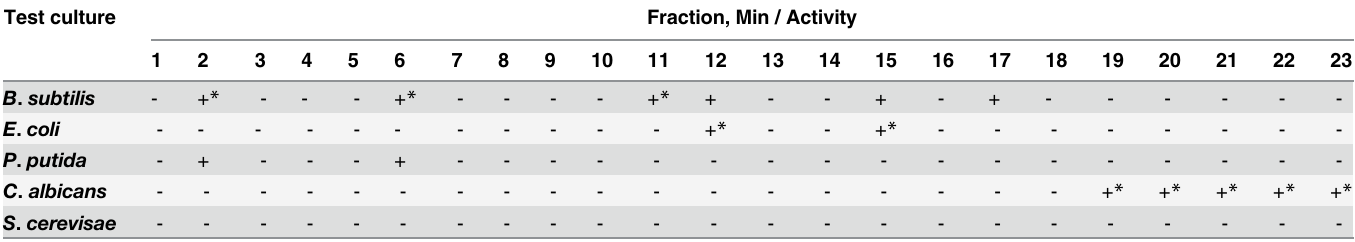
Table 3. Antimicrobial activity in separated fraction extract obtained from liquid culture of strain Streptomyces sp . IB 2014/I/78-8 grown on DNPM media. Test